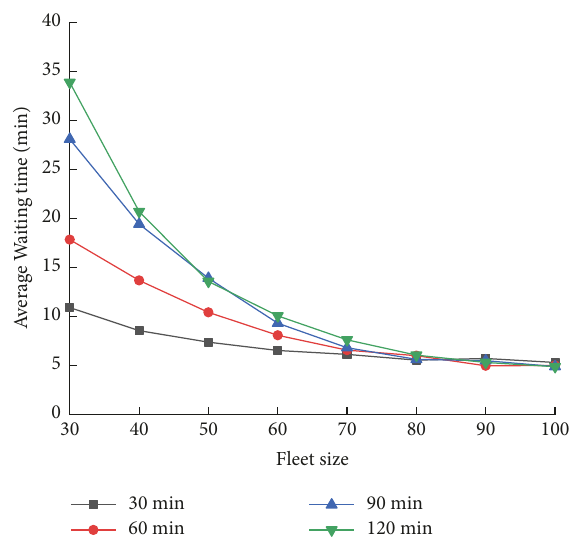
Figure 12: Performance of waiting time with varying bus fleet size.